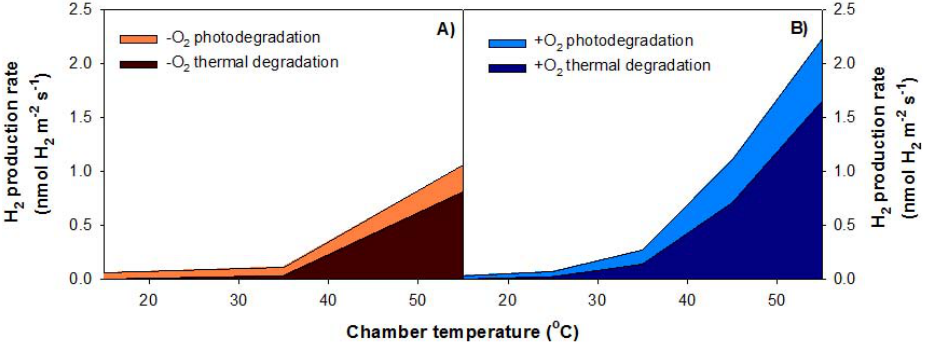
Fig. 3. The rate of H 2 production during thermal degradation (dark colors; measured in the absence of solar radiation) and photodegradation (light colors; H 2 production in the presence of solar radiation minus thermal degradation) of high lignin proxy basswood sheet in the (a) absence of O 2 and (b) presence of O 2